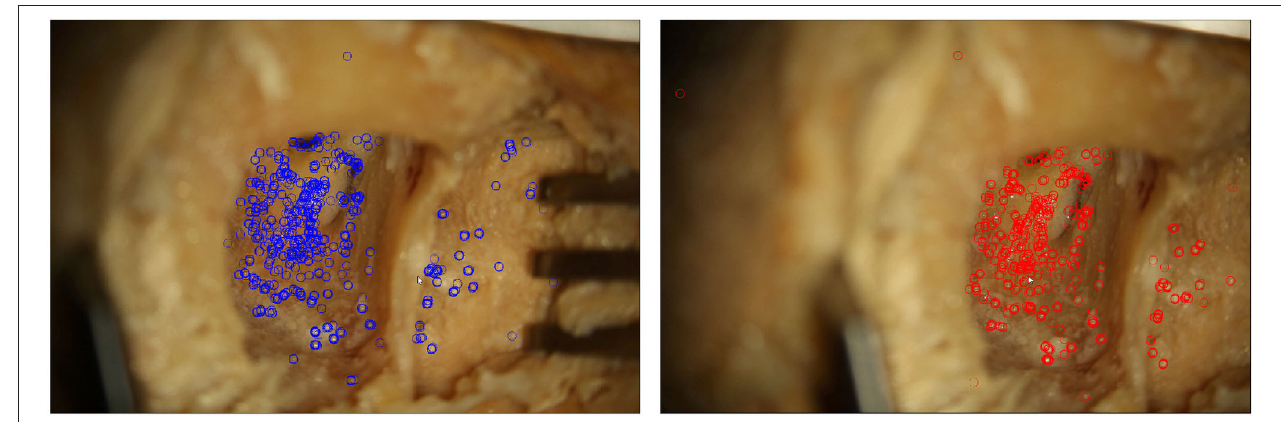
FIGURE 3 | Two microscope images of a moving situs. In each frame, features detected by the proposed algorithm are